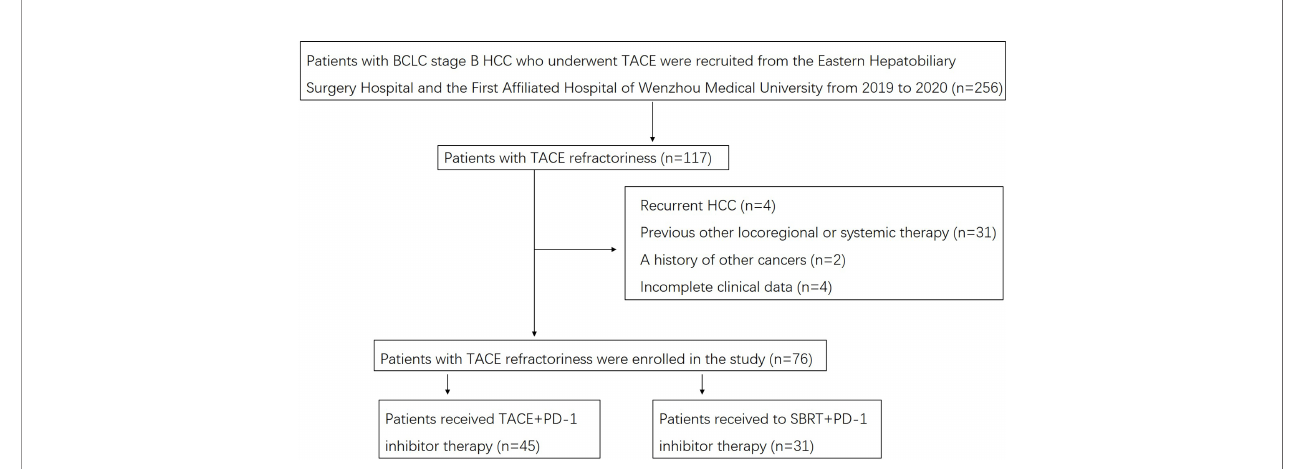
FIGURE 1 | Flow diagram for the present study. BCLC, Barcelona Clinic Liver Cancer; HCC, hepatocellular carcinoma; TACE, transarterial chemoembolization; SBRT, stereotactic body radiation